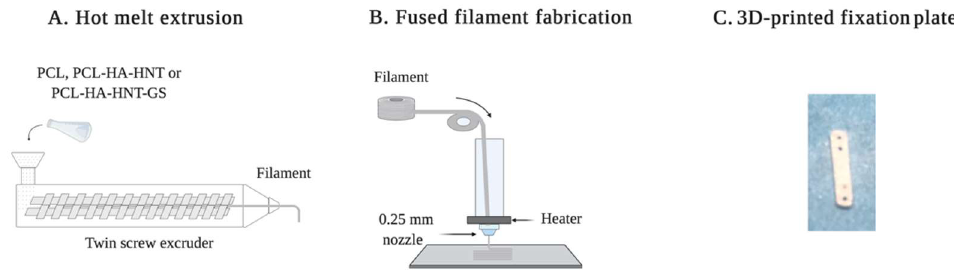
Figure 1. Schematic representation of ( A ) the hot melting extrusion process and ( B ) the fused filament fabrication printing process. ( C ) Picture of a 3D-printed fixation plate by fused filament fabri- cation.